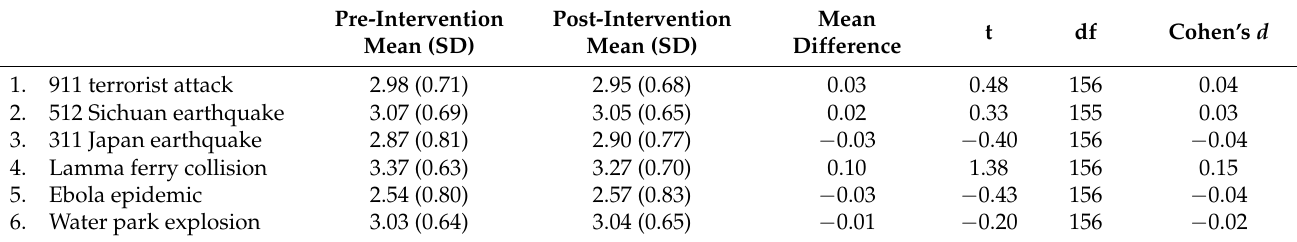
Table 4. Comparison between pre- and post-intervention for